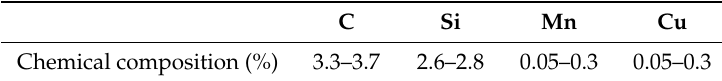
Table 1. Chemical composition of Sibodur ® 450.